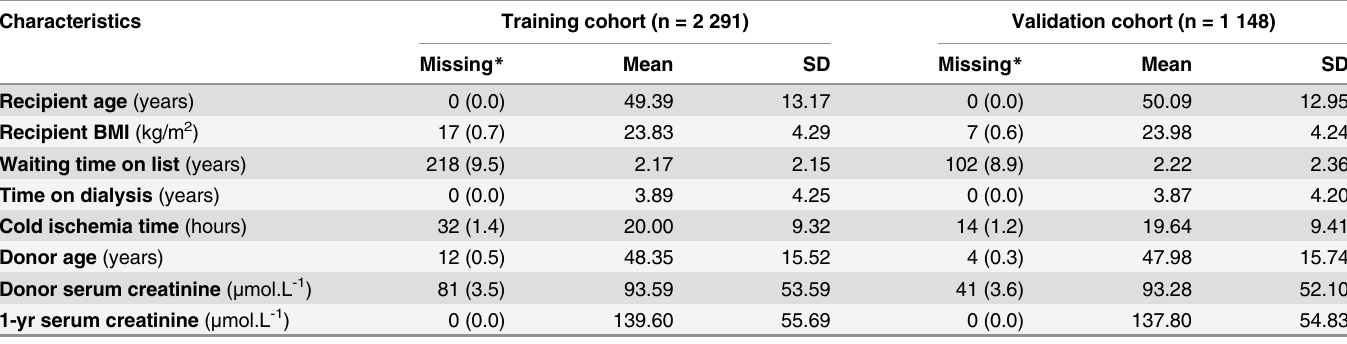
Table 1. Recipient, transplantation and donor quantitative characteristics at transplantation or at 1-year of transplantation of the training and vali- dation samples (mean, standard deviation and missing values).